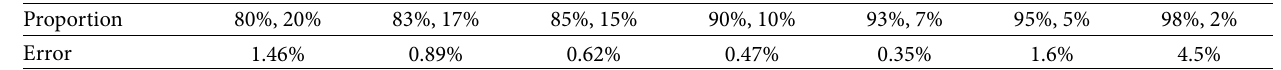
Table 7: The prediction errors using multiple proportions.